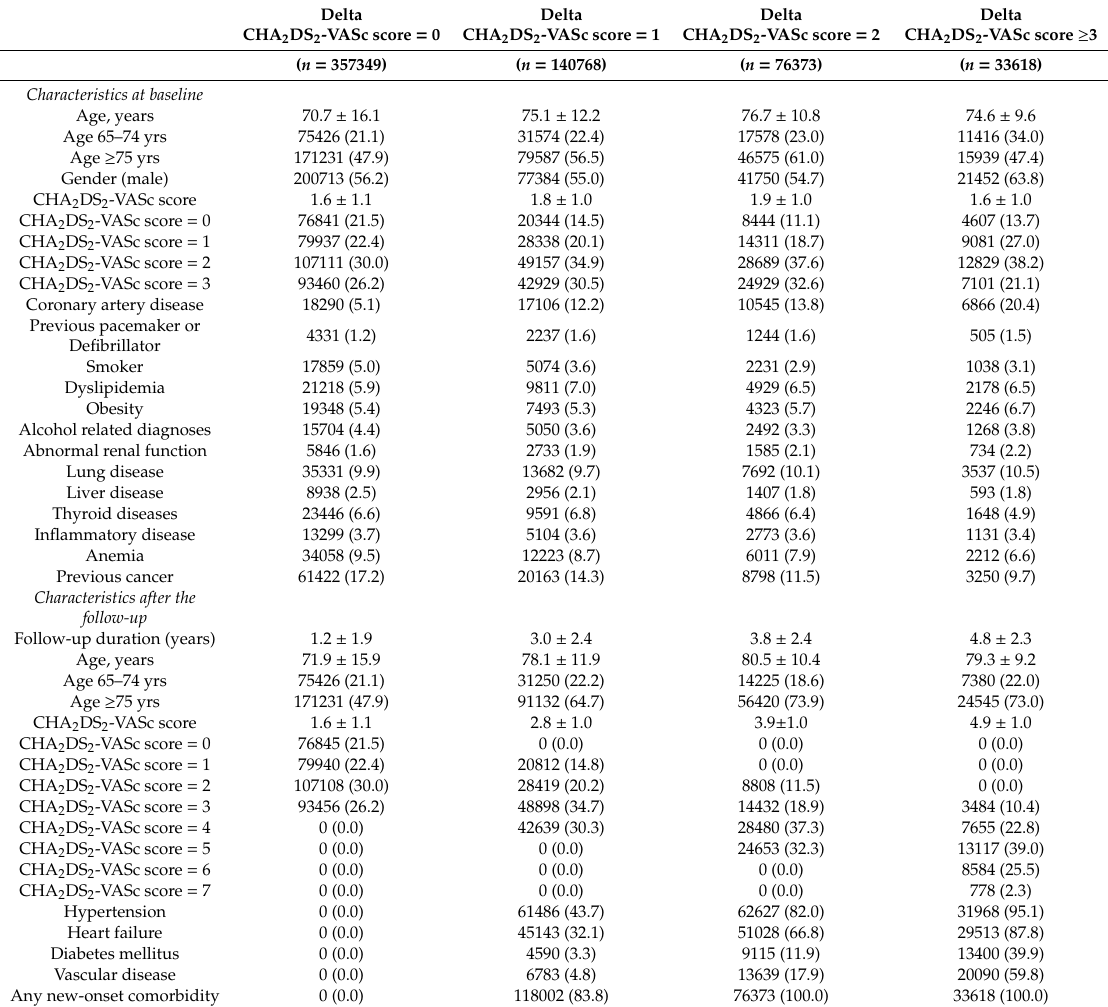
Table 2. Characteristics of patients with AF stratified by delta CHA 2 DS 2 -VASc